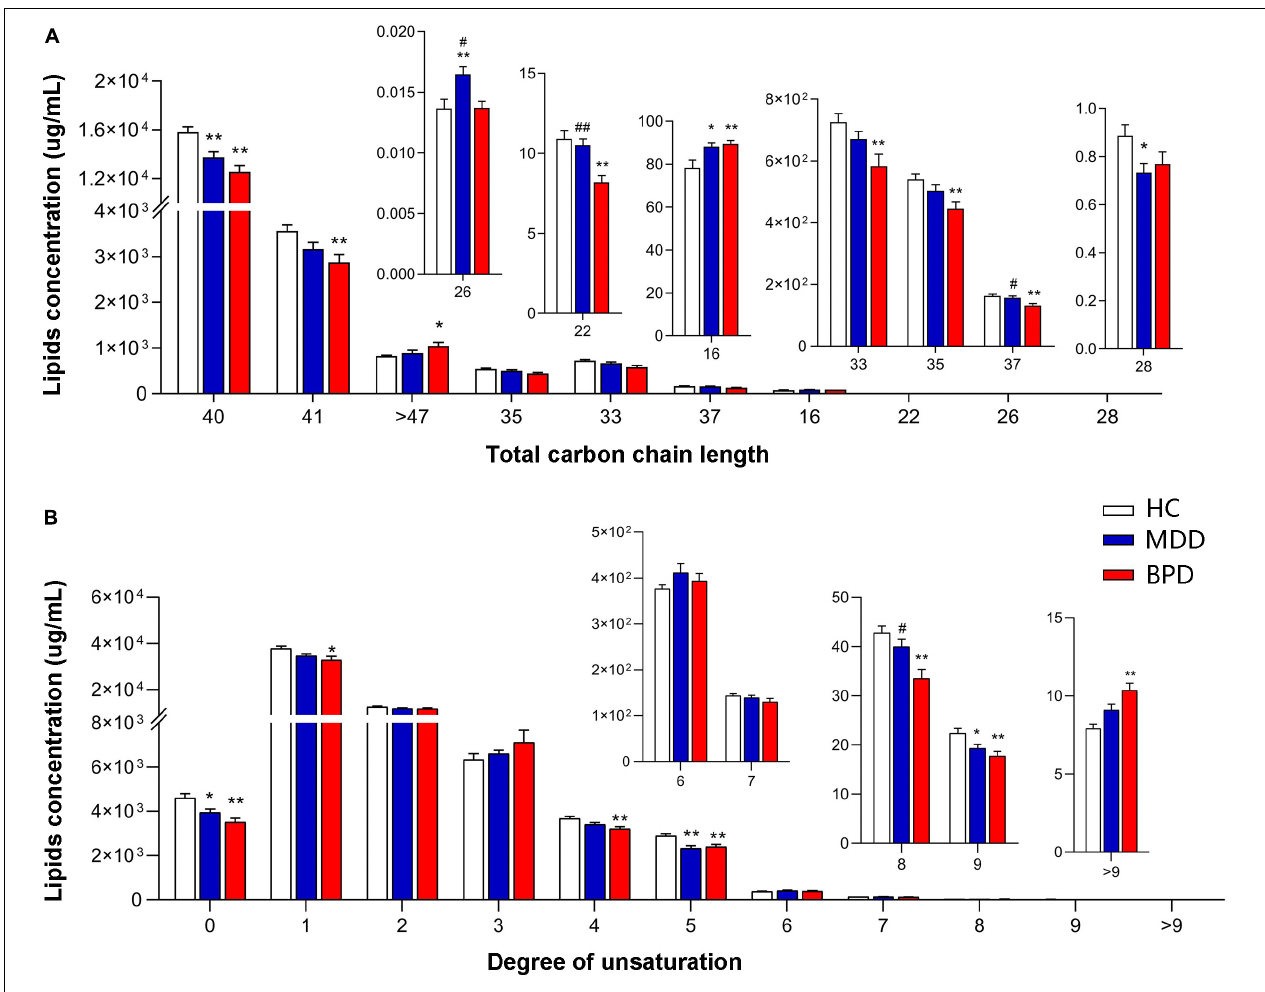
FIGURE 2 | Groupwise alterations in fatty acid composition in the plasma. Results of analysis of fatty acyl composition by (A) chain length (number of carbons) and (B) degree of unsaturation. Lipids showing low levels results have been enlarged in insets. HC, health control; MDD, major depressive disorder; BPD, bipolar depression; * P < 0.05 vs. HC; ** P < 0.01 vs. HC; # P < 0.05 vs. BD; ## P < 0.01 vs.